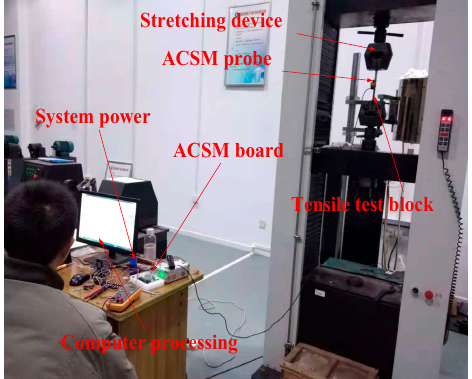
Figure 20. Assembly drawing of the static tensile test block.